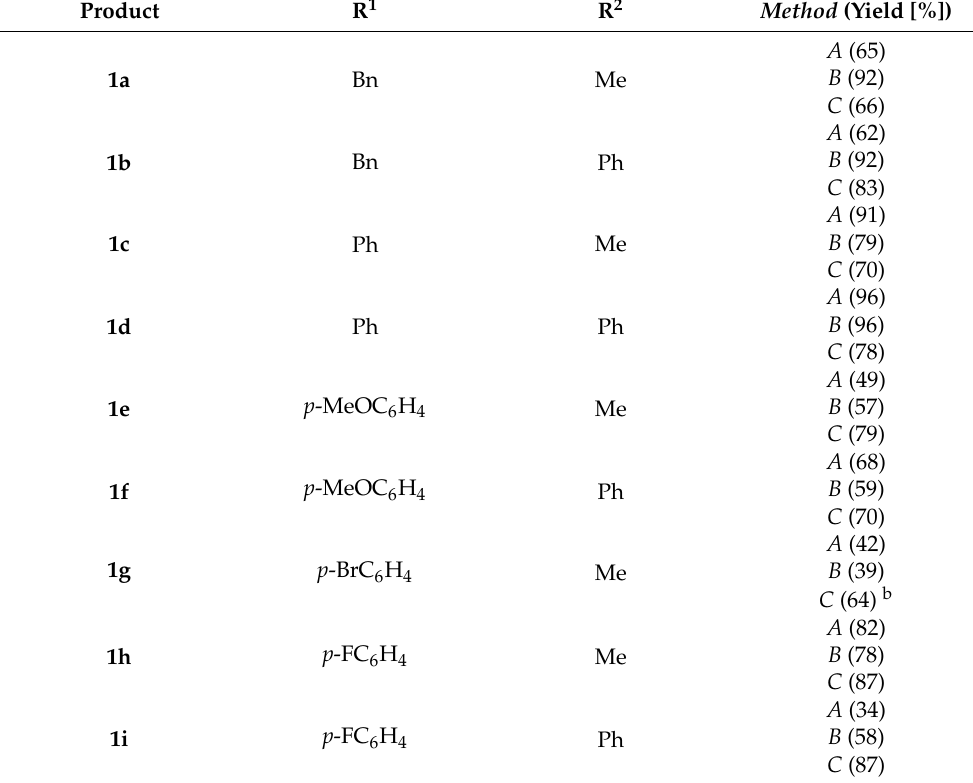
Table 1. Synthesis of imidazole N -oxides 1a – 1i by using Methods A - C : Scope of substrates a . Product